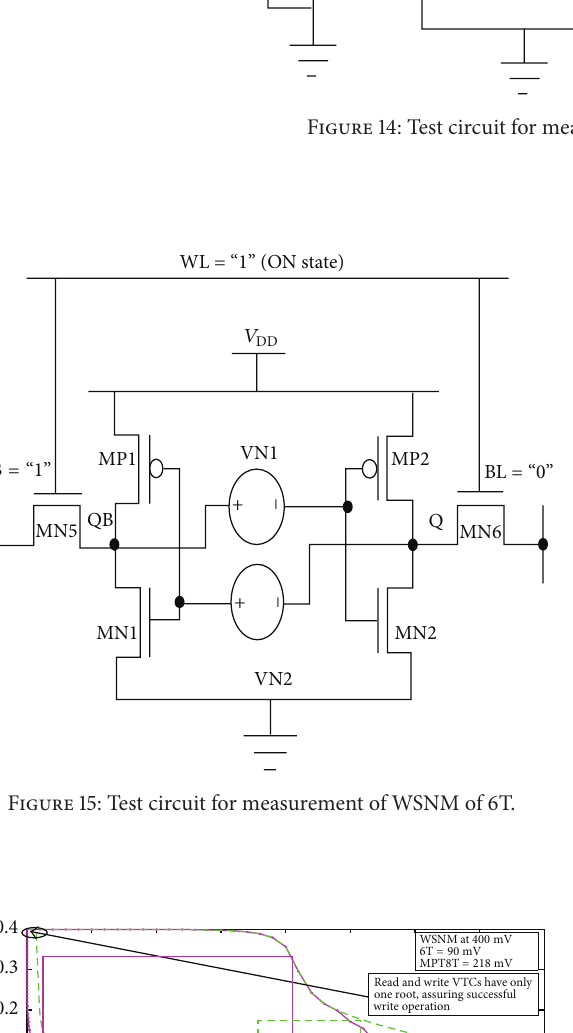
Figure18:TestcircuitforextractingN-curveofMPT8Tduringread